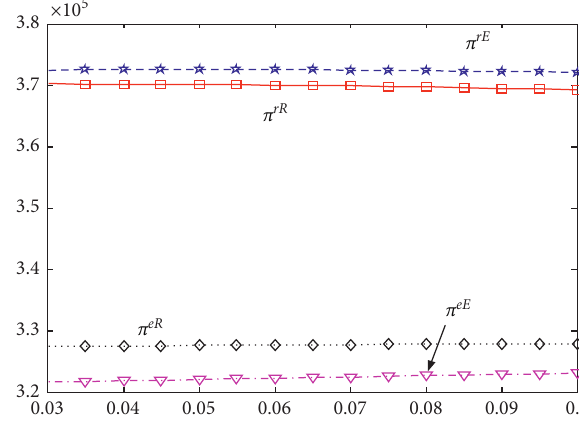
Figure 6: Optimal profit of the seller over ρ .